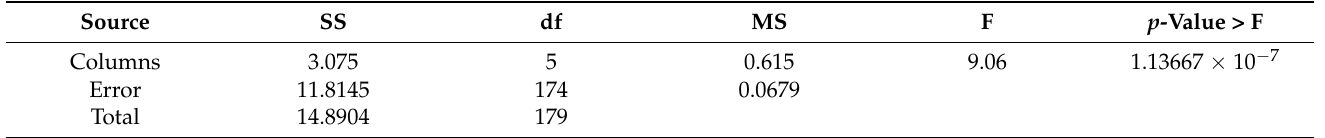
Table 3. ANOVA numeric